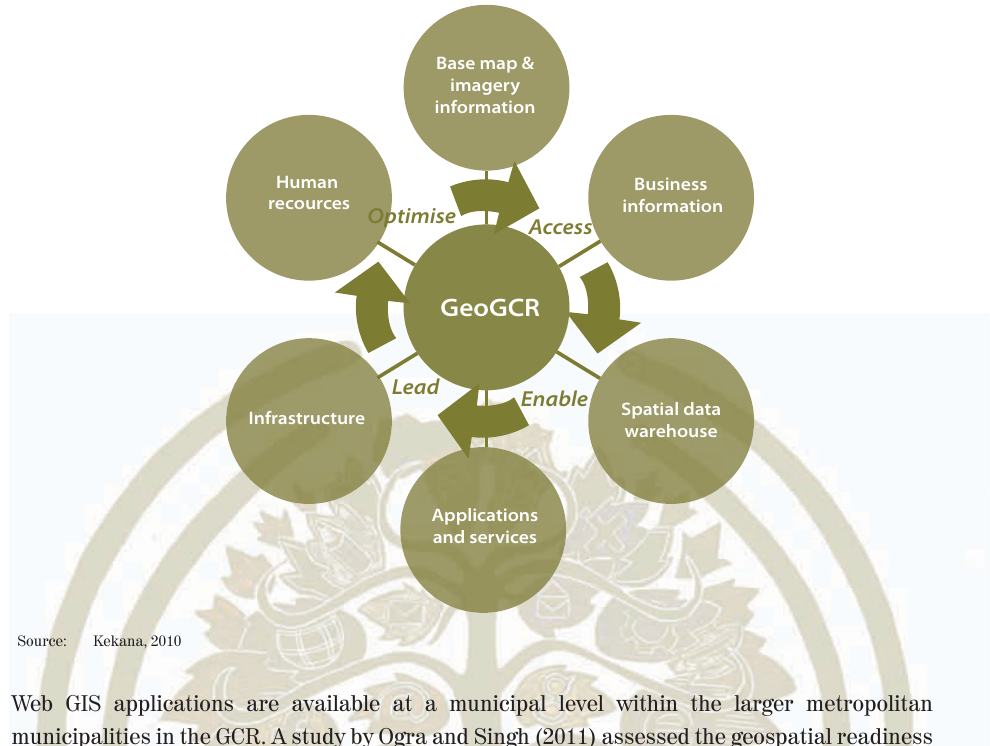
FIGURE 4: THE BUILDING BLOCKS OF THE GAUTENG